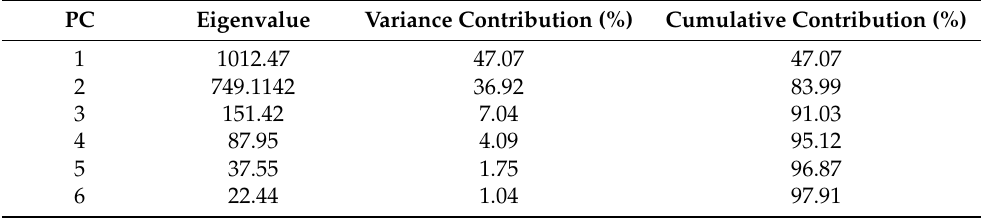
Table 1. Results of Principal Component Analysis (PCA).